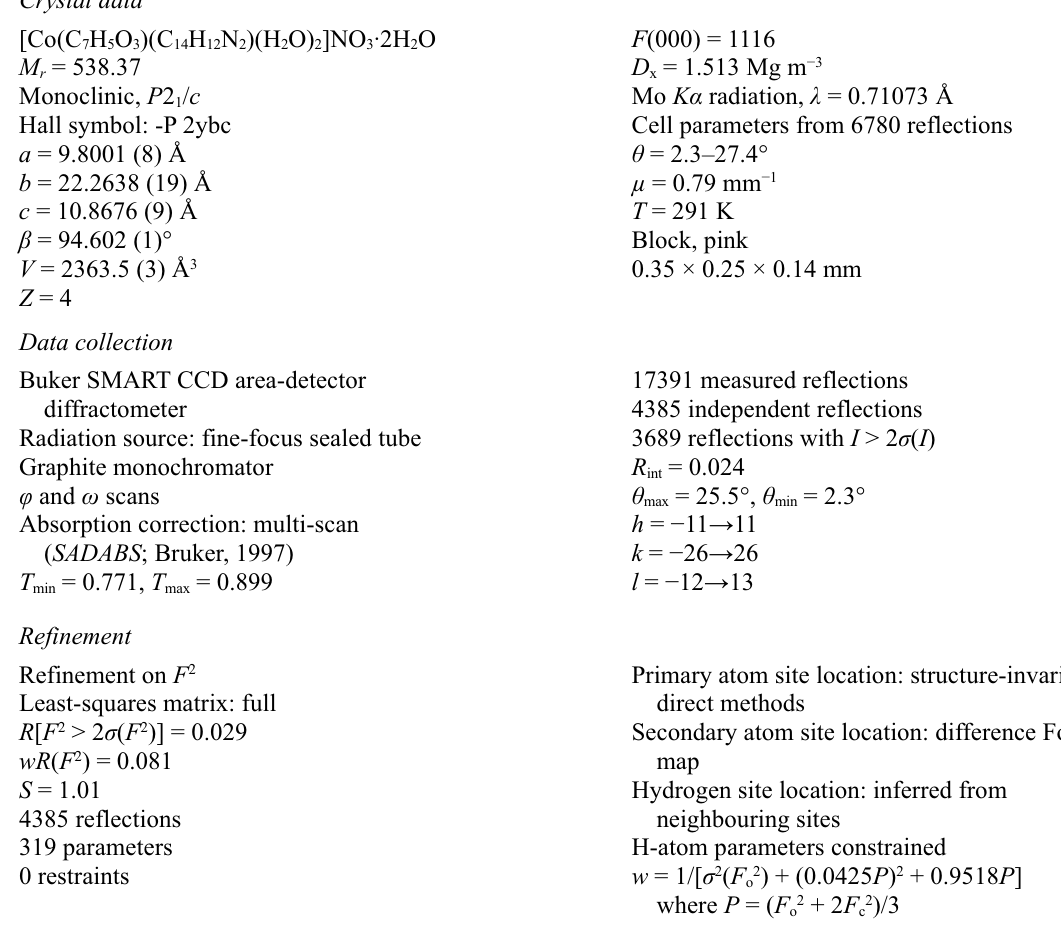
The crystal structure of the title compound, viewed along the c axis. Hydrogen bonds are shown as dashed lines. Diaqua(2,9-dimethyl-1,10-phenanthroline- κ 2 N , N ′ )(4- hydroxybenzoato- κ 2 O , O ′ )cobalt(II) nitrate dihydrate Crystal